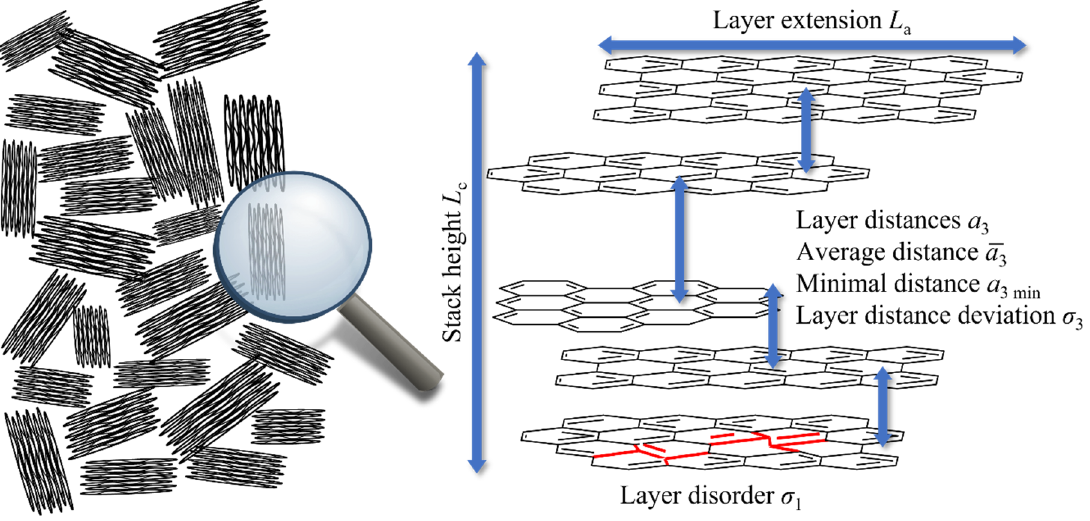
Figure 1. Sketch of the structural make-up of non-graphitic carbons (NGCs) containing a turbostratic stacking of graphenes. Detailed information about all parameters can be found in Section 2.2.